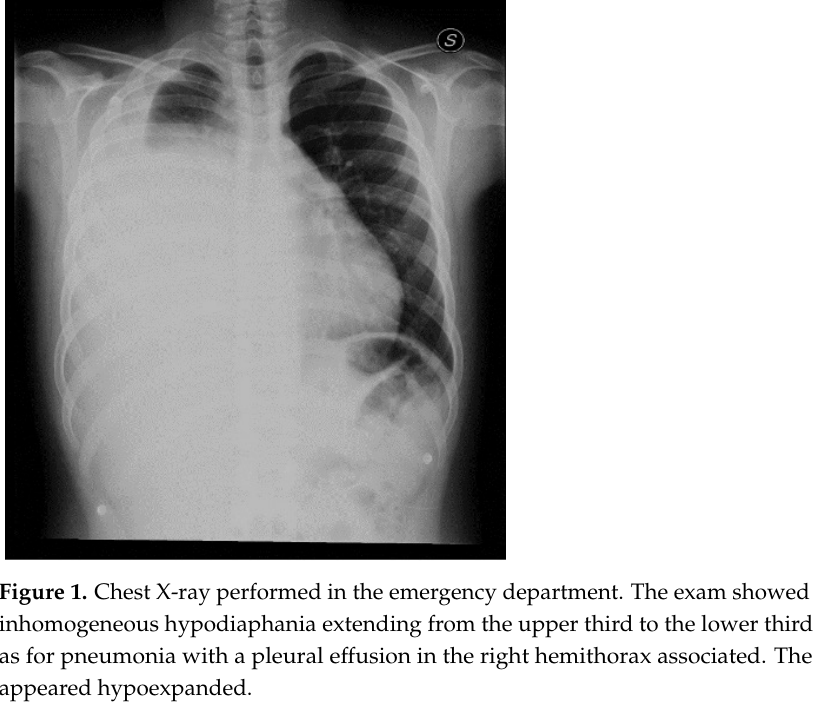
Figure 1. Chest X-ray performed in the emergency department. The exam showed an extensive and inhomogeneous hypodiaphania extending from the upper third to the lower third of the right lung as for pneumonia with a pleural effusion in the right hemithorax associated. The upper lung pole appeared hypoexpanded.